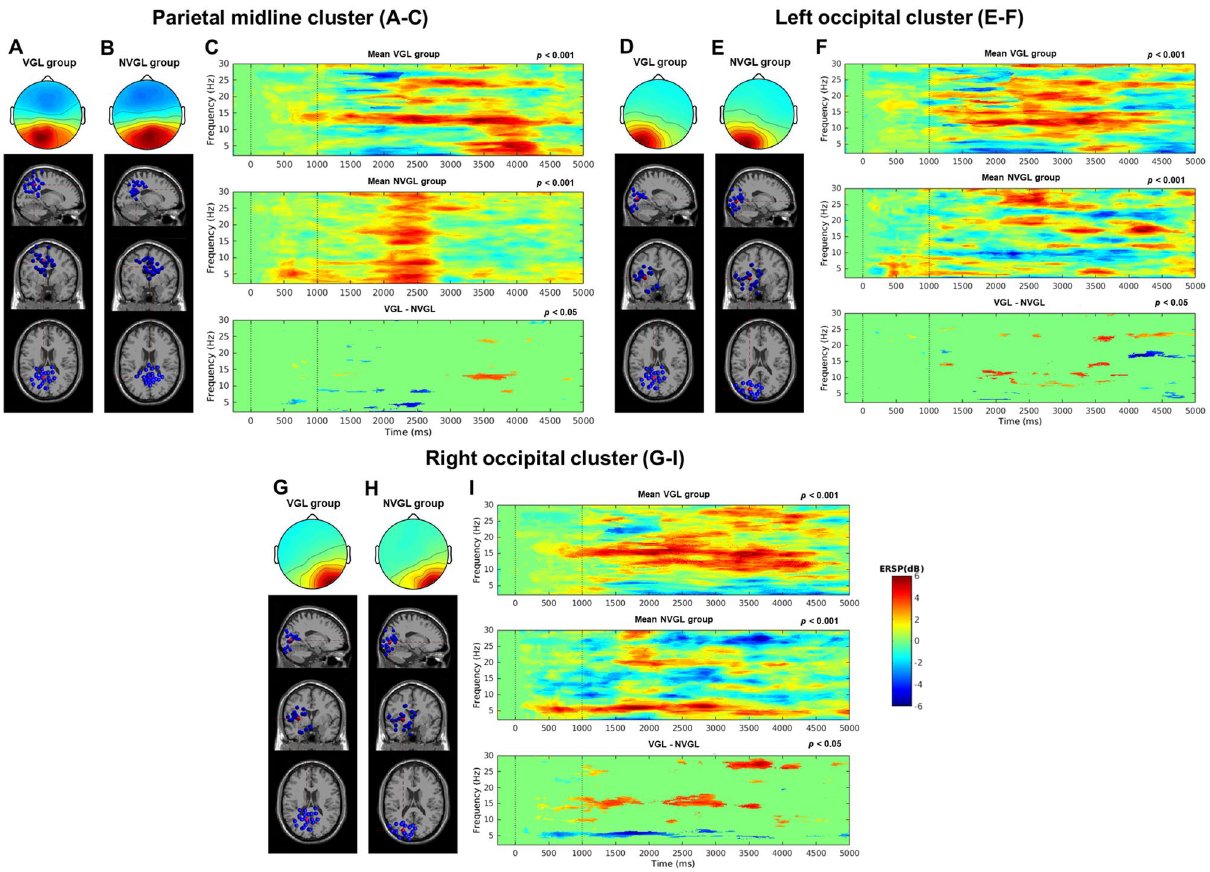
Figure 5. Parietal midline cluster (MNI coordinates: VGL group, x = 15, y = −53, and z = 33; NVGL group, x = 7, y = −26, and z = 45), left occipital cluster (MNI coordinates: VGL group, x = −22, y = −58, and z = 17; NVGL group, x = −11, y = −99, and z = −3) and right occipital cluster (MNI coordinates: VGL group, x = 15, y = −87, and z = −15; NVGL group, x = 29, y = −91, and z = −8). (a,b,d,e,g,h) Scalp maps and equivalent dipole locations of independent components at the sagittal, coronal, and top view for VGL group ( a,d,g ) and NVGL group ( b,e,h ) in parietal midline cluster ( a,b ), left occipital cluster ( d,e ) and right occipital cluster ( g,h ). ( c,f,i ) ERSPs in VGL and NVGL groups, as well as significant differences between two group conditions (ERSPs of VGL group minus the ERSPs of NVGL group) with p < .05 from parietal midline ( c ), left occipital ( f ) and right occipital ( i ) clusters (first dotted lines at the 0 ms time point signify the onset of a trial, and the second dotted lines at the 1000 ms time point signify the onset of stimuli). For all ERSPs, non-significant points were masked with zero values in the mean ERSPs and are displayed in green. Significant differences with respect to baseline activity are displayed in red and blue for positive and negative deviations from the baseline activity,